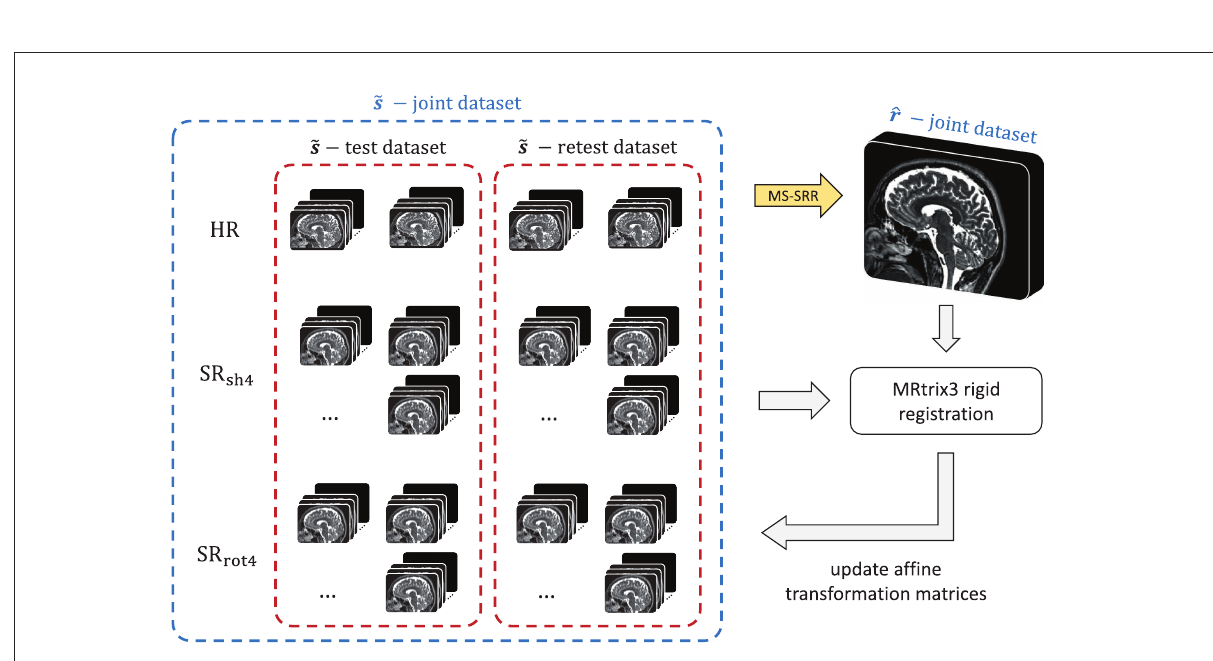
FIGURE3 Workflow of the model-based iterative registration algorithm for joint motion correction of the MS